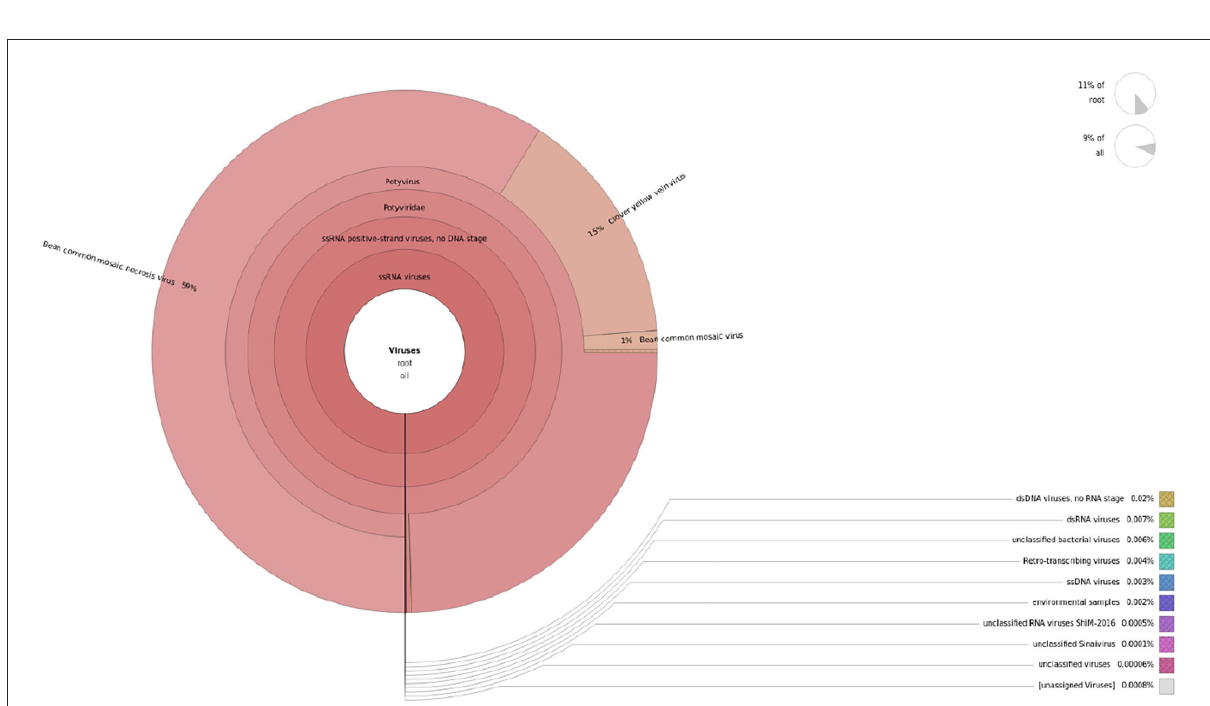
FIGURE2 Krona representation of viral sequencing data obtained from